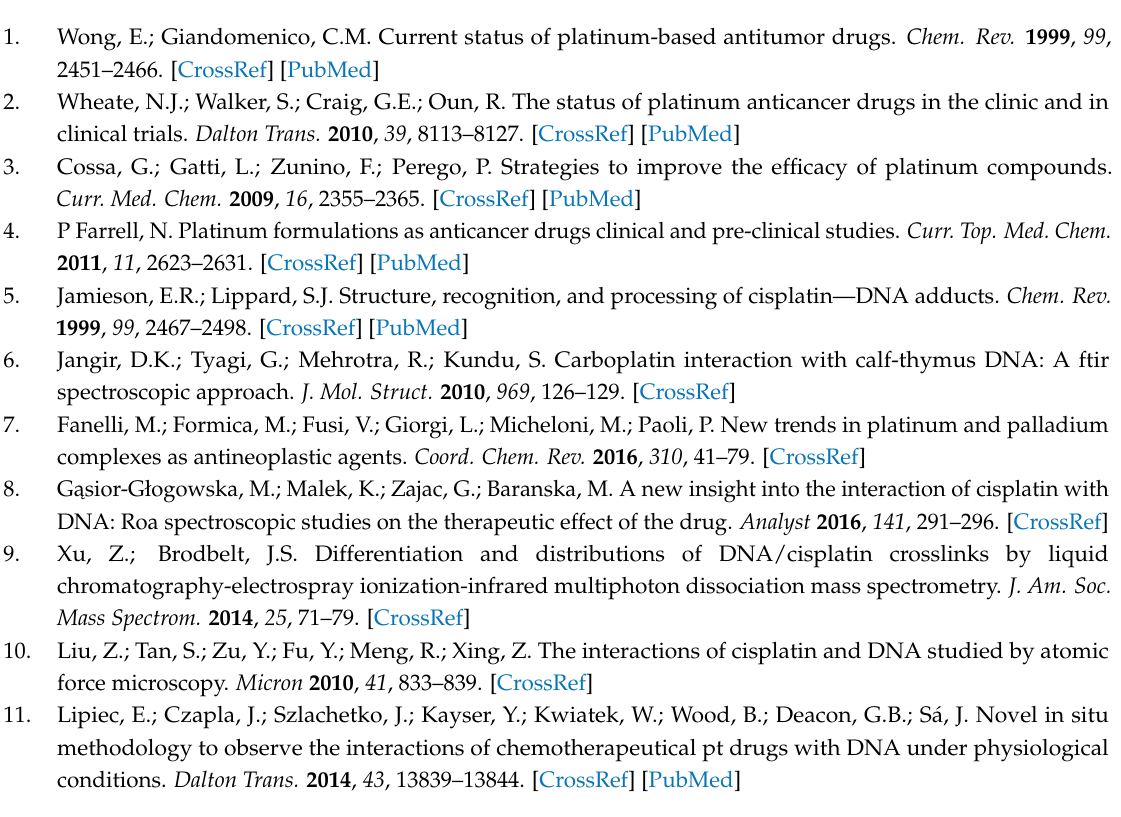
s1, Figure S1: FTIR-IR absorbance spectra of the control with buffer and acetone, DNA-drug samples with cisplatin and PFB. Figure S2: ATR-IR spectrum of PFB. Figure S3: 1 HNMR spectrum of PFB. Figure S4: 19 FNMR spectrum of PFB. Figure S5: ESMS + spectrum of PFB. Figure S6: ATR-IR spectrum of TMB. Figure S7: 1 HNMR spectrum of TMB. Figure S8: 19 FNMR spectrum of TMB. Figure S9: ESMS + spectrum of